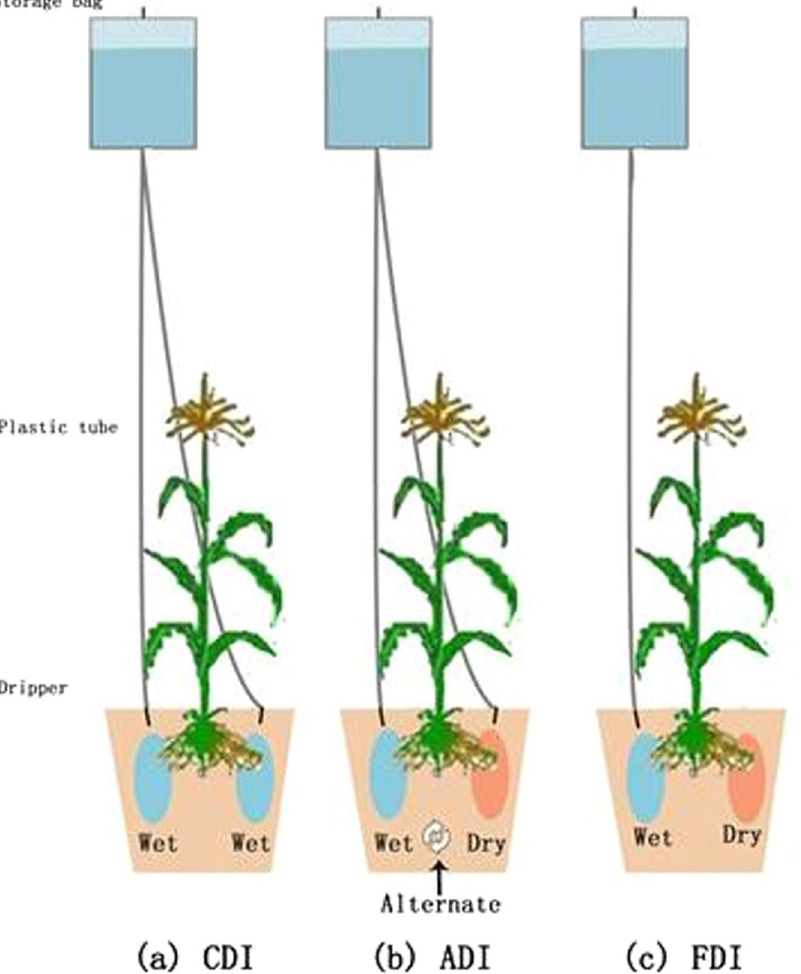
Figure 4. Layout of drip irrigation imitation system for three drip irrigation methods. ( a ) CDI: conventional drip irrigation (both halves of the pot simultaneously irrigated by two drippers), ( b ) ADI: alternate partial root– zone drip irrigation (both halves of the pot alternately irrigated by one dripper), ( c ) FDI: fixed partial root–zone drip irrigation (only one fixed half of the pot irrigated by one